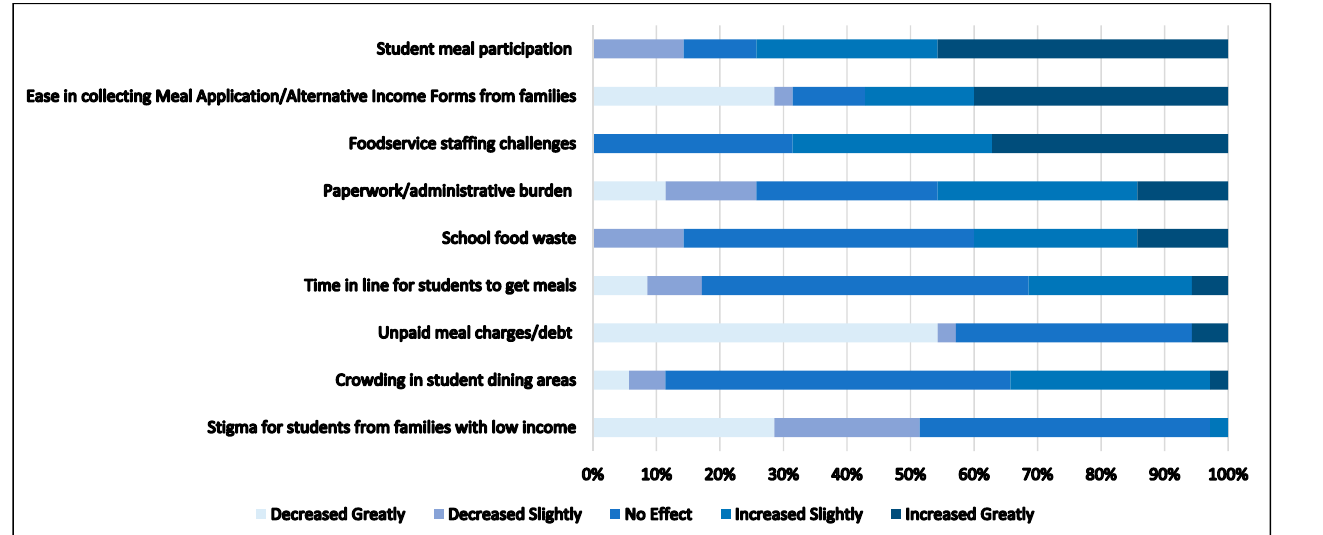
Figure 2. Perceptions of Changes Due to Implementing Universal School Meals in School Year 2021–2022 among School Food Authorities in Maine ( n = 35). Surveys restricted to School Food Authorities not previously participating in the Community Eligibility Provision (CEP).